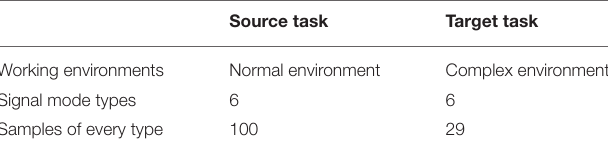
TABLE 1 | Signal mode types and samples of every type under normal and complex environments using transfer learning with LeNet-5.